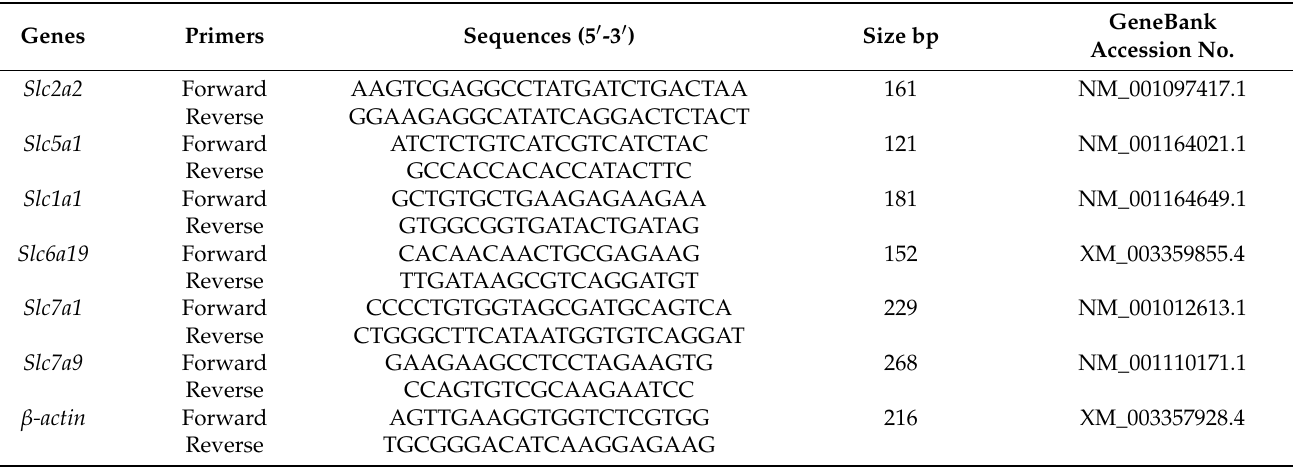
Table 1. Primers used for real-time PCR